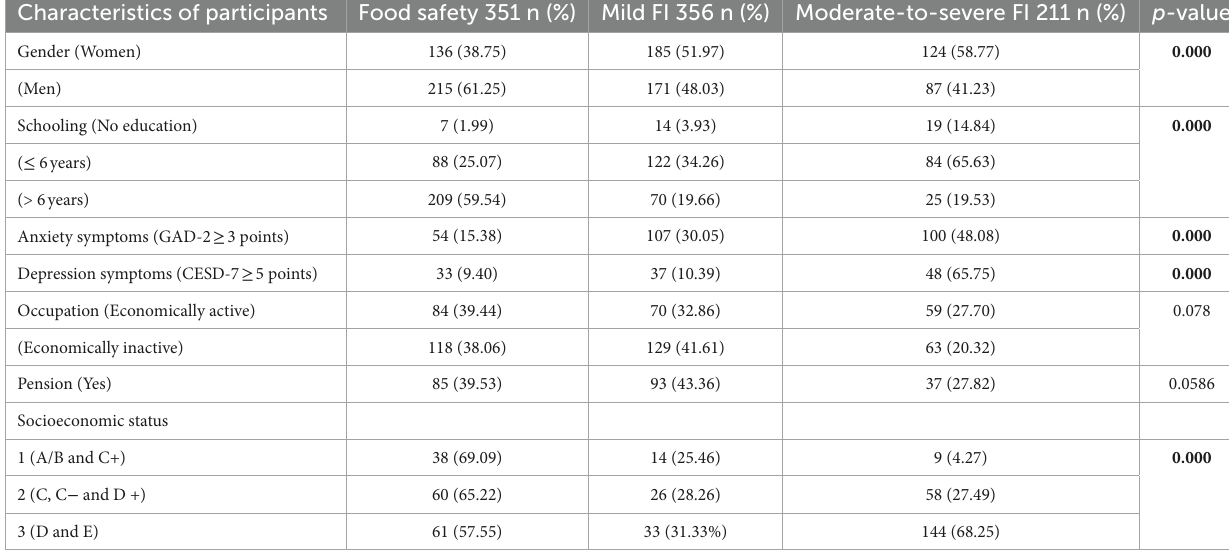
TABLE 2 Comparison of the variables by the level of food insecurity. Characteristics of participants